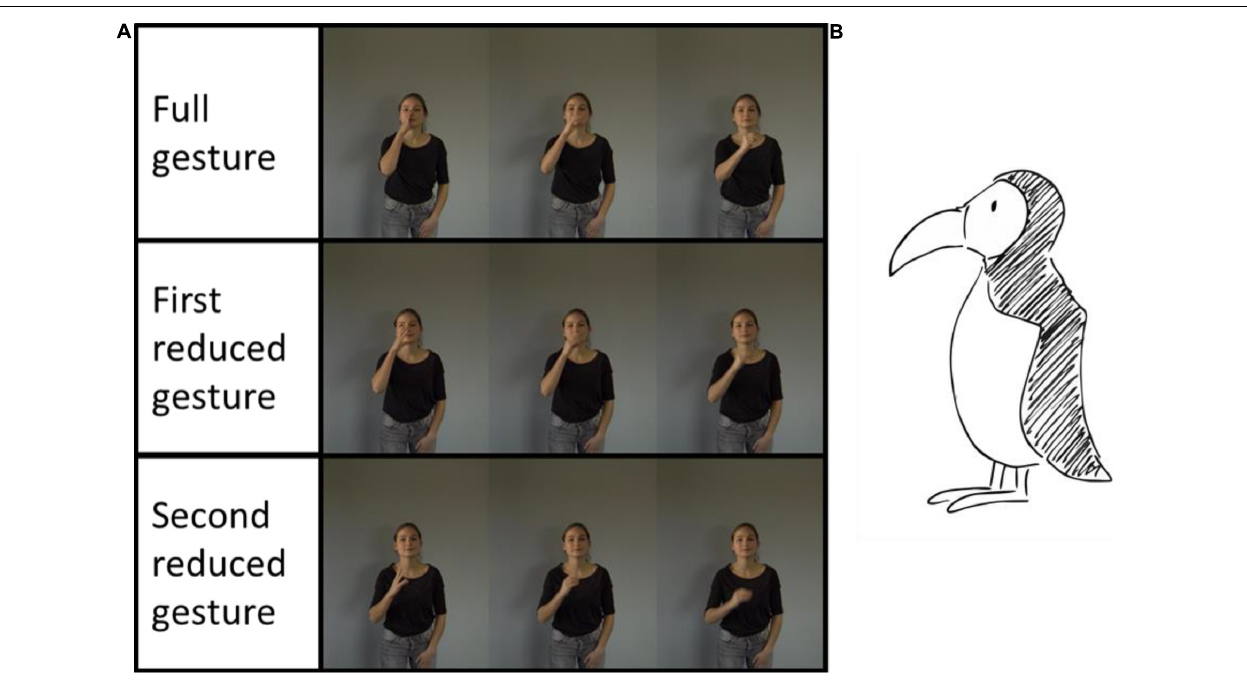
FIGURE 1 | (A) The three gesture versions of the iconic gesture for the noun “auk”. The first row depicts the fully executed gesture; the second row depicts the first reduced gesture version; the third row depicts the second reduced gesture version. (B) The picture displays the referent “auk” (Copyright © 2013 Joy Katzmarzik leap4joy graphics; reprinted with